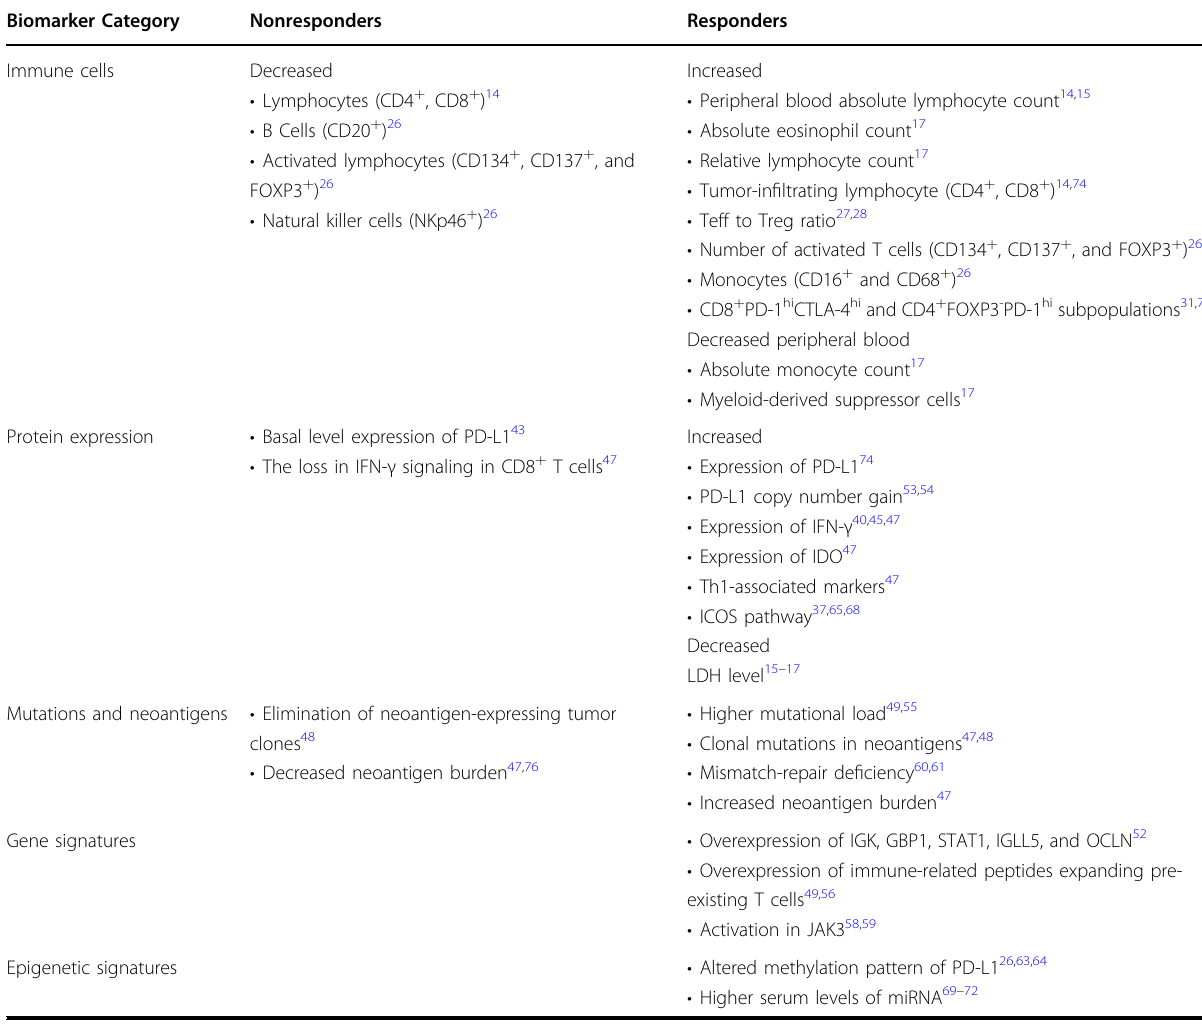
Table 2 Predictive biomarkers for progression-free survival and overall survival in patients treated with immune checkpoint